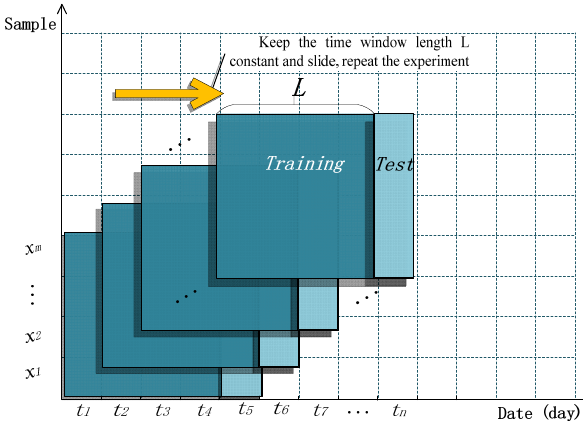
Figure 4. Segmentation of dataset.